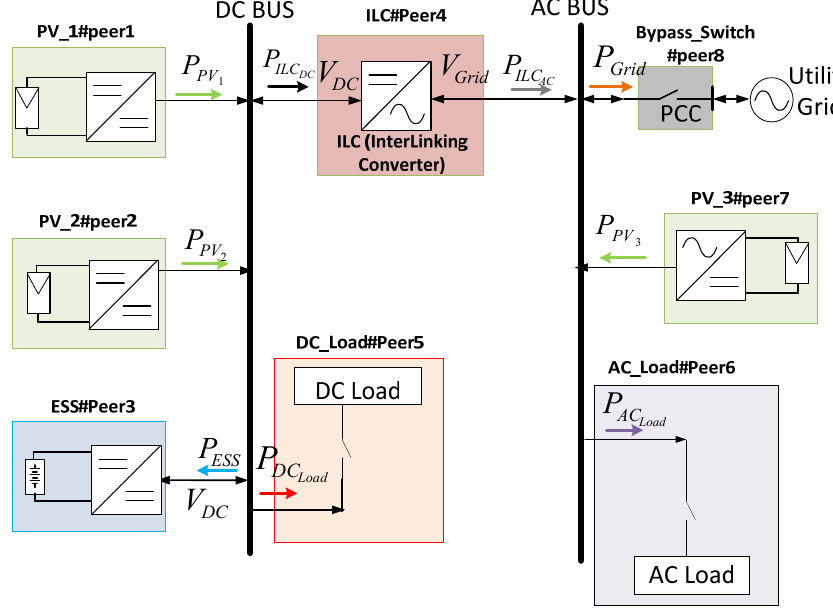
Figure 10. DHT layer pseudo-code. Detail of embedded application layer.